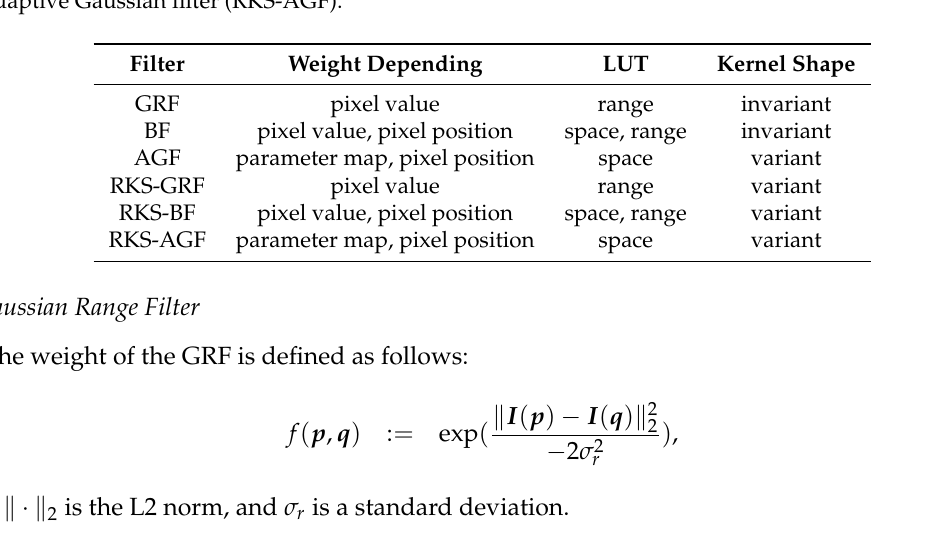
Table 2. Characteristics of the Gaussian range filter (GRF), the bilateral filter (BF), the adaptive the randomly-kernel-subsampled bilateral filter (RKS-BF), and the randomly-kernel-subsampled adaptive Gaussian filter